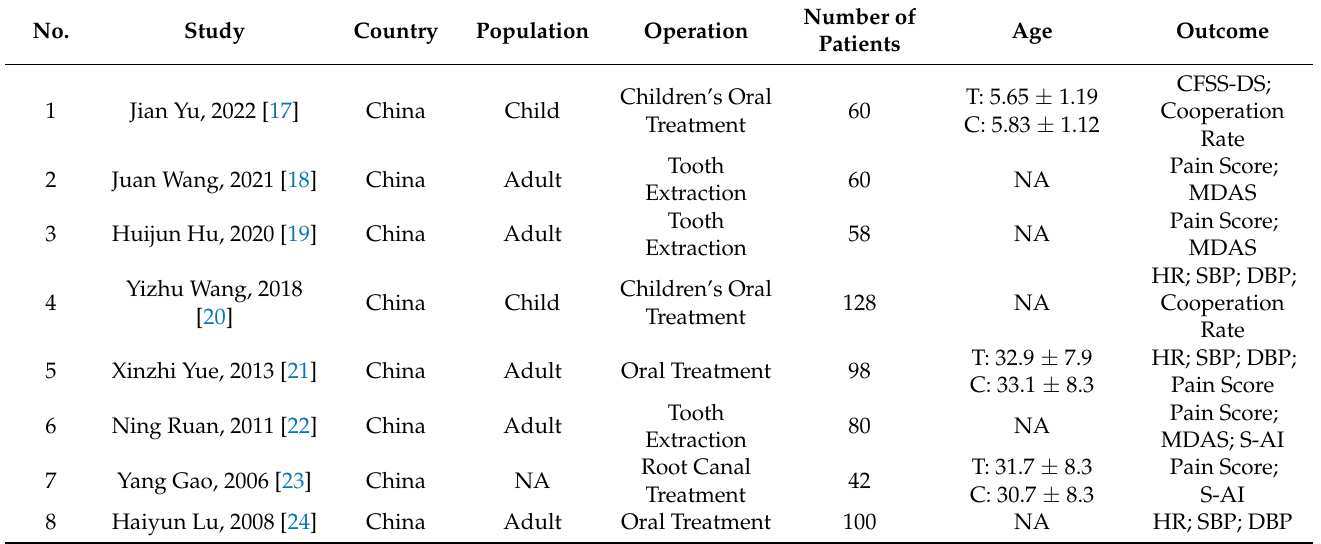
Table 2. Characteristics of included studies.